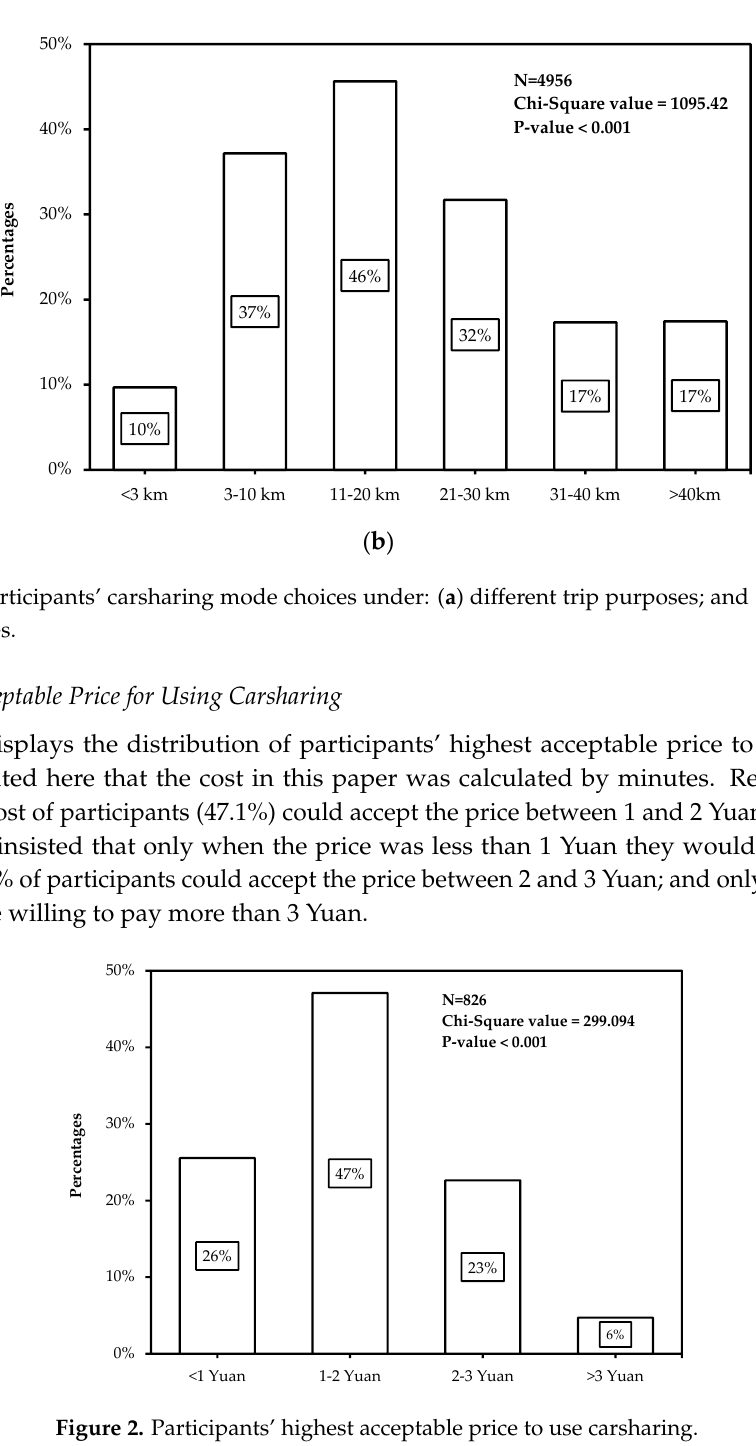
Figure 2. Participants’ highest acceptable price to use carsharing.